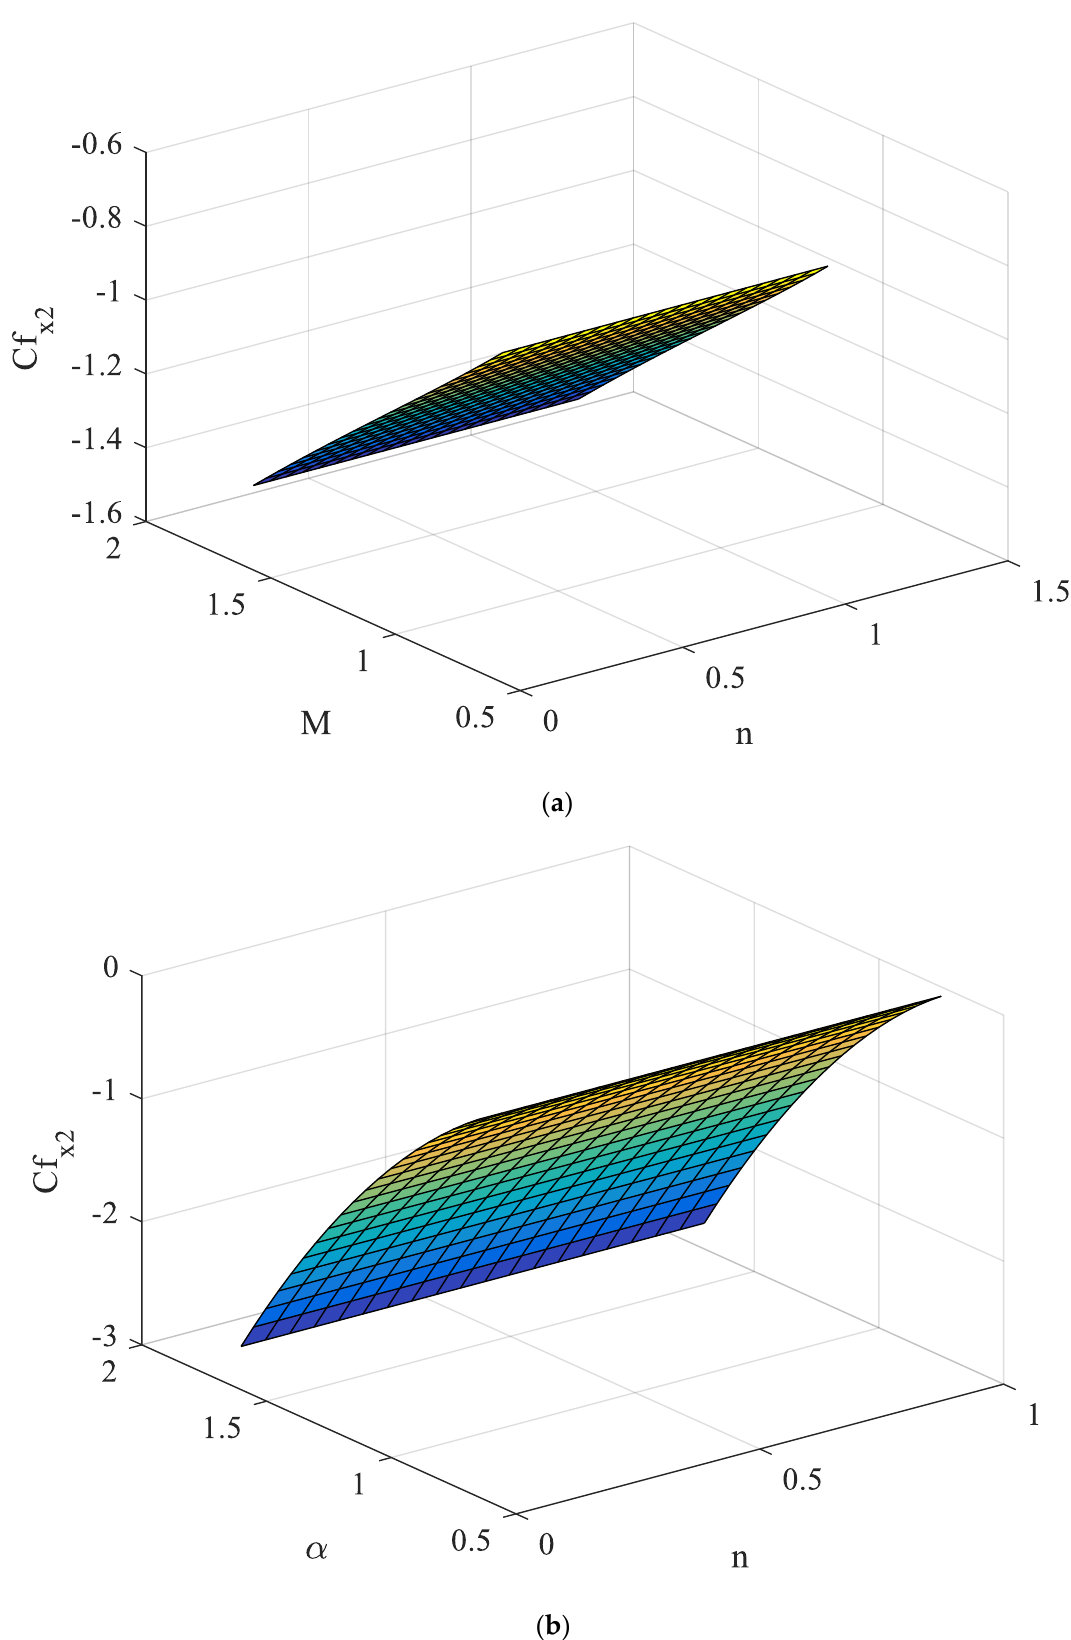
C f -direction for different values of M & n . ( b ): Three-dimensio- -direction for different values of 2 2 x Cf -direction for different values of 2 x